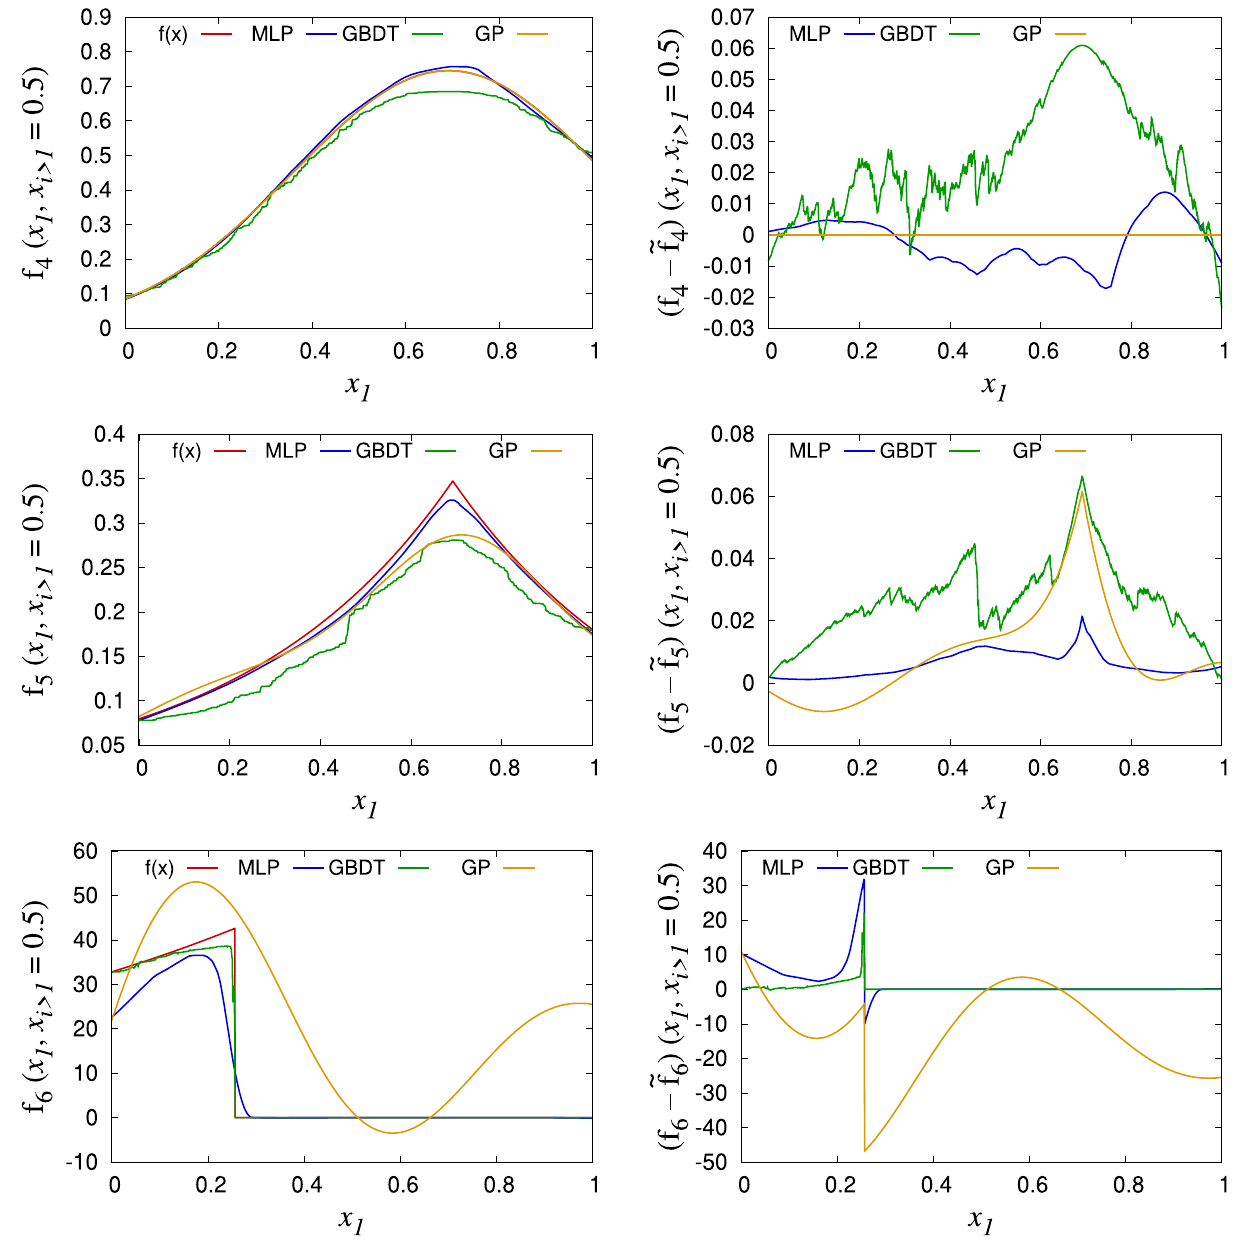
for N ≈ 5000 , D=8, and || c || 1 = 8.0 . Those are plotted as a function of x 1 , while rest of the x are fixed to x i = 2,3, ... ,8 = 0.5